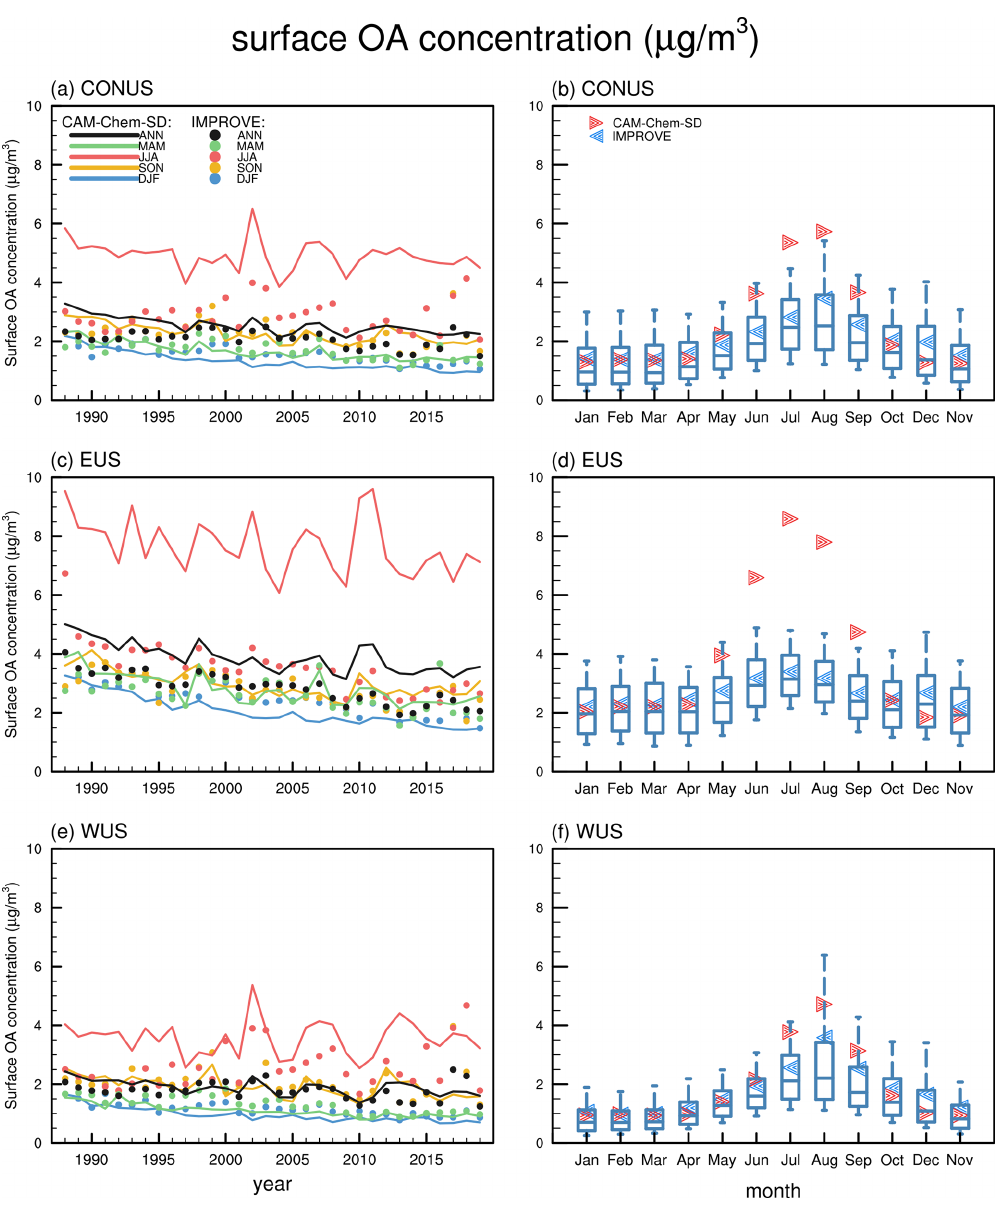
Figure 2. The left column is the 1988–2019 annual mean (black lines) and seasonal average (blue lines for winter, green lines for spring, red lines for summer, and yellow lines for autumn) surface OA concentrations of IMPROVE (solid dots) and CAM-Chem-SD (solid lines) over the US continent (CONUS) (a) , the eastern US (EUS) (c) , and the western US (WUS) (e) . The right column is the seasonal cycle of 1988–2019 average surface OA concentrations of IMPROVE (blue dots) and CAM-Chem-SD (red dots) over CONUS (b) , EUS (d) , and WUS (f) . Every blue box denotes the 10th, the 25th, the median, the 75th, and the 90th percentiles of the observations for all selected sites in each